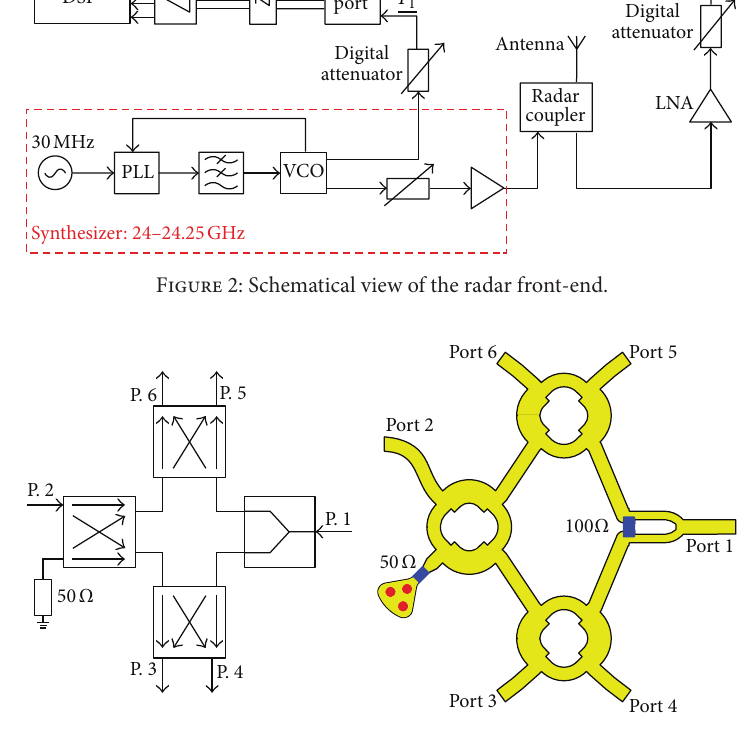
Figure 3: Schematical view and layout of the Six-port